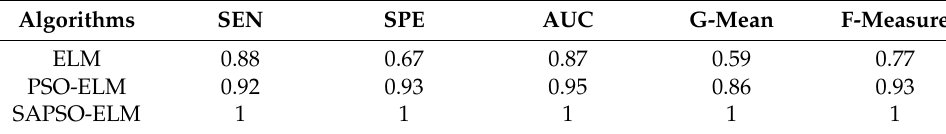
Figure 6. ROC curve of three groups of prediction models. Table 7. Performance indicators of three groups of prediction models.